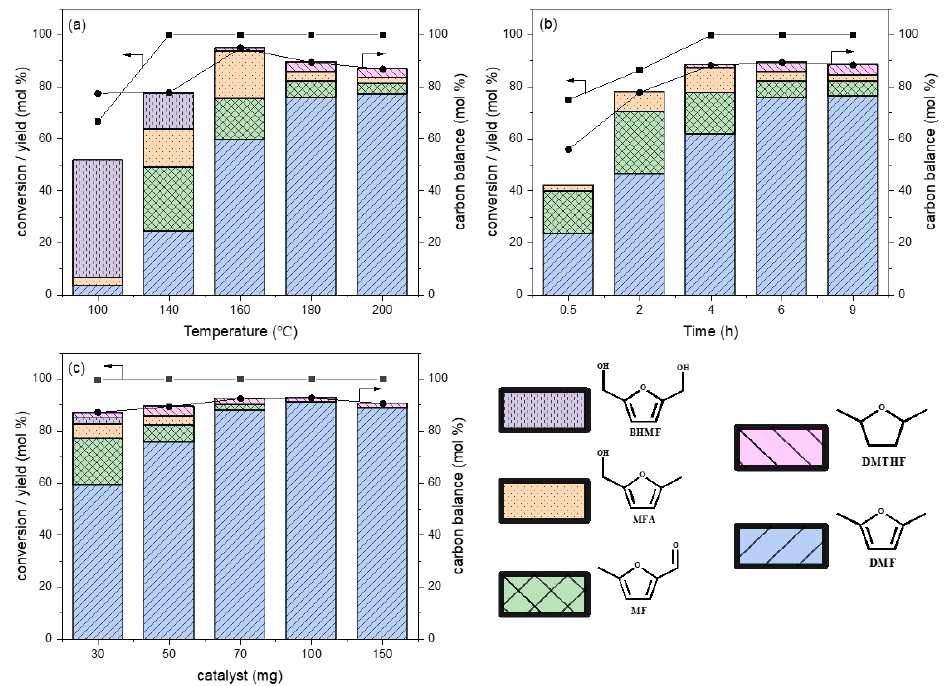
Figure 6. Effect of reaction temperature ( a ), reaction time ( b ) and catalyst loading ( c ) on HMF hydrogenolysis over 0.5% Pt-2% FeO x /AC. Reaction conditions: ( a ) P (H 2 ) = 1.5 MPa, t = 6 h, stirring speed = 600 rpm, m HMF = 250 mg, m catalyst = 50 mg, V n-butanol = 20 mL. ( b ) T = 180 °C, P (H 2 ) = 1.5 MPa, stirring speed = 600 rpm, m HMF = 250 mg, m catalyst = 50 mg, V n-butanol = 20 mL. ( c ) T = 180 °C, p (H 2 ) = 1.5 MPa, t = 6 h, stirring speed = 600 rpm, m HMF = 250 mg, V n-butanol = 20 mL.